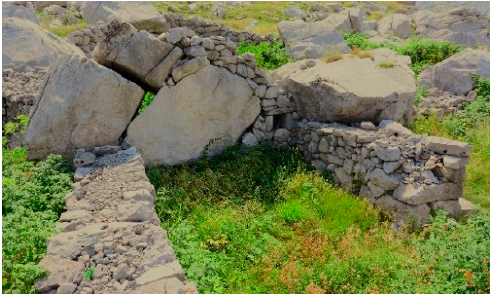
Figure 14. Existing rocks and larger blocks of stones were used for parts of gladas’ walls. Studenica, photo: I. Lakovi ć .